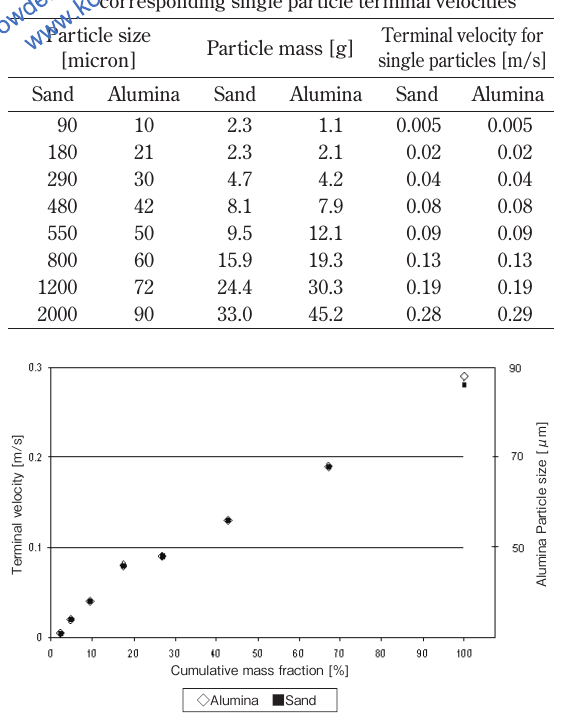
Fig. 6 Mass fraction vs the single particle terminal ve- locity of alumina and sand microns was sieved off from the alumina because the corresponding size of the sand particles with the same terminal velocity would otherwise become too large for the experimental set-up.